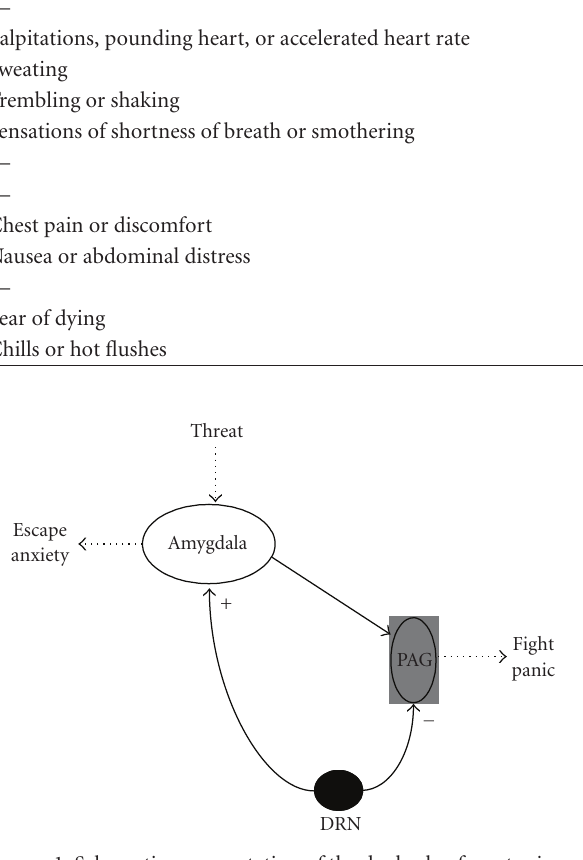
Figure 1: Schematic representation of the dual role of serotonin on fear and anxiety, according to Deakin and Grae ff